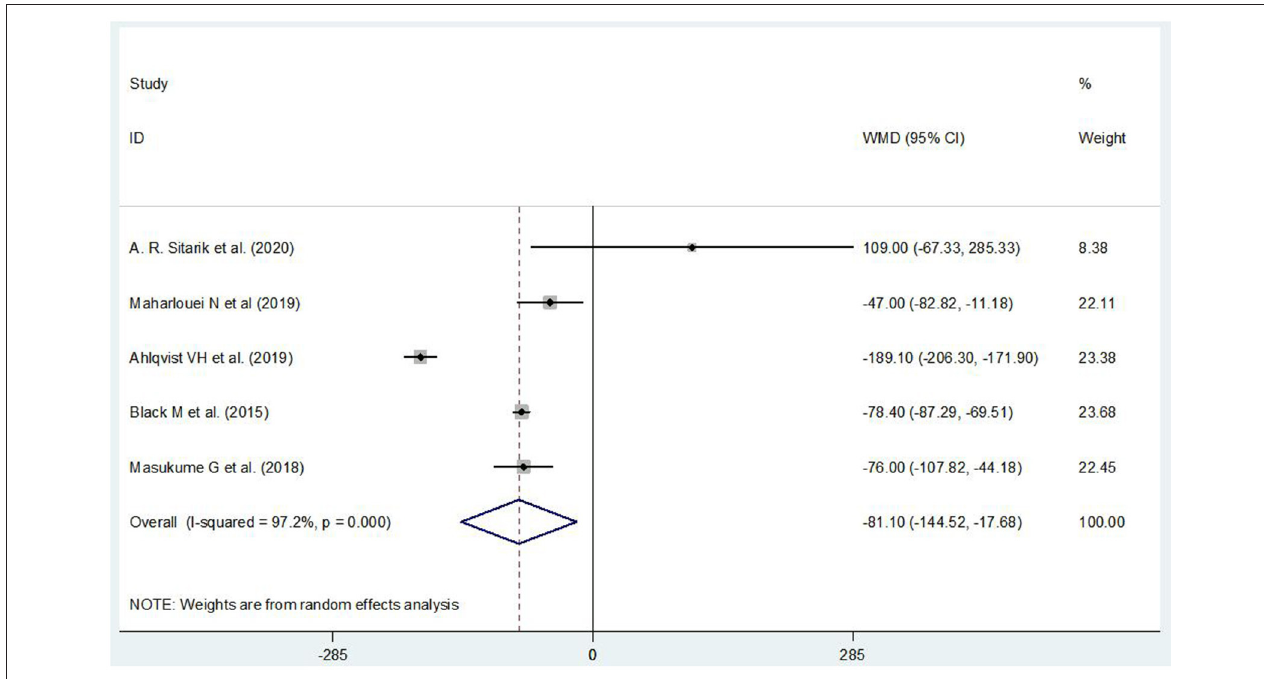
FIGURE 2 | The association between ECS and infants’ birth weight.